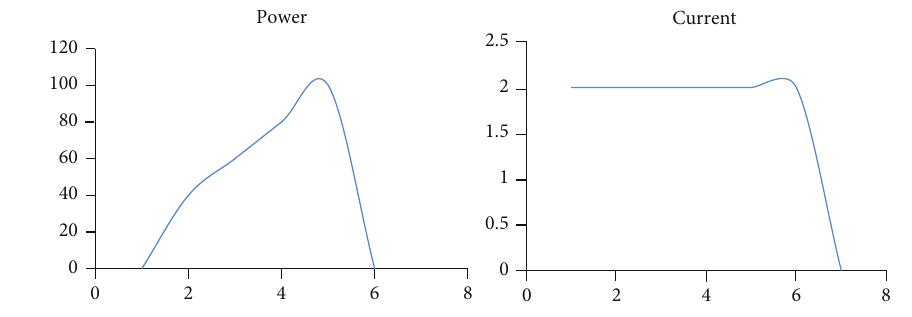
Figure 6: The curves of power voltage and the current voltage.